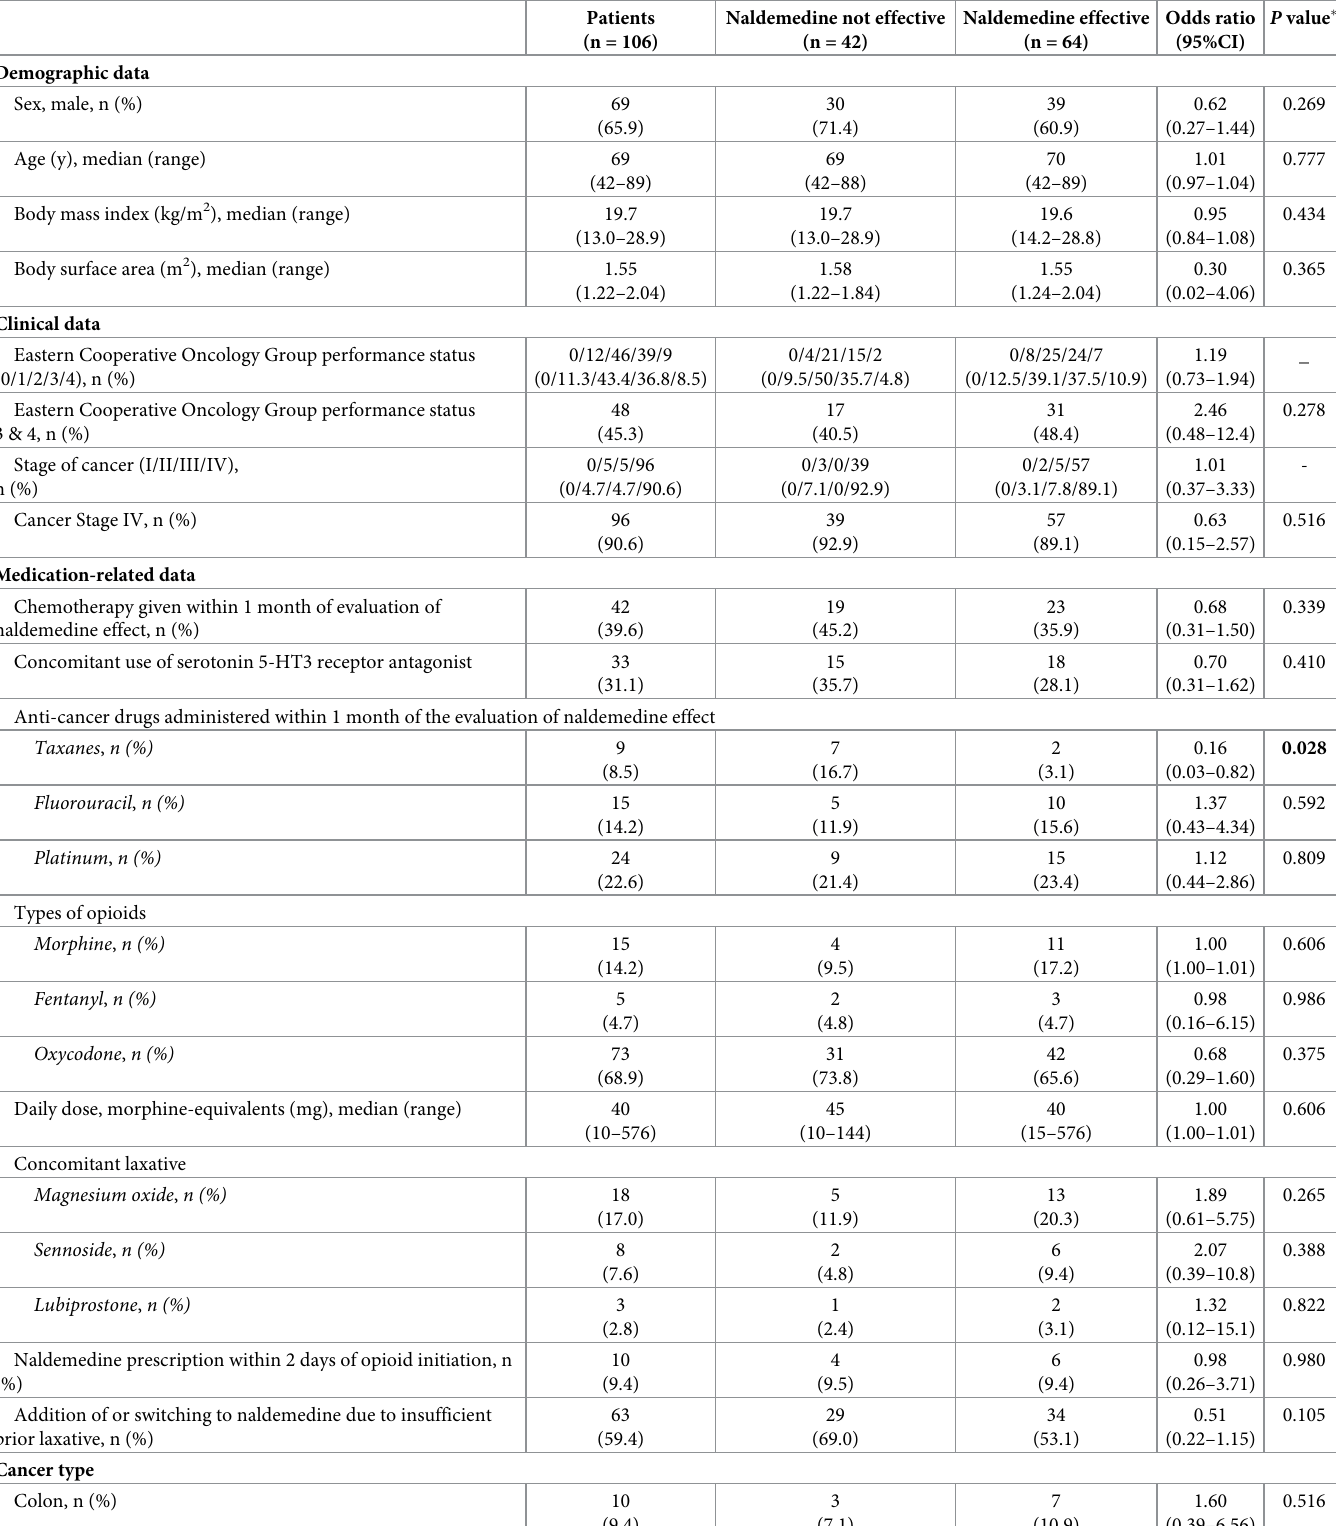
Table 2. Extracted variables, and results of univariate logistic regression analyses (n =